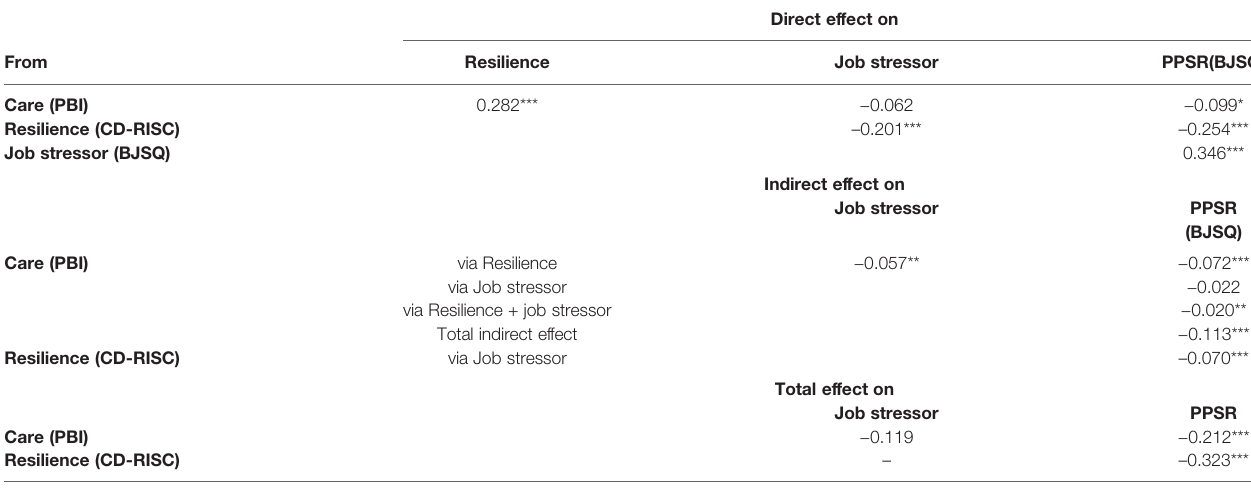
TABLE 3 | Standardized path coef fi cients between each variable of parental